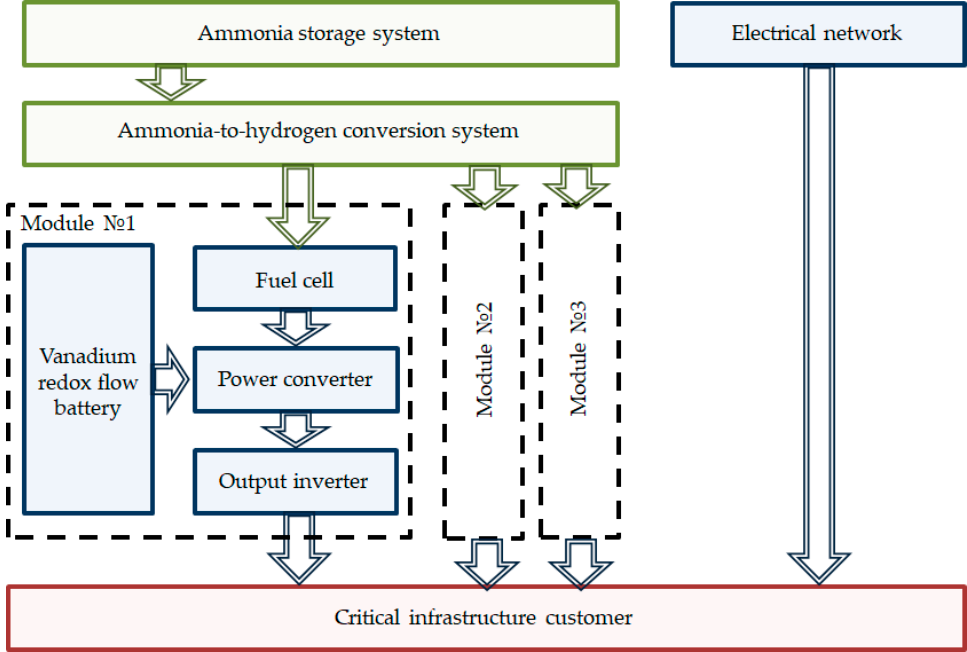
Figure 7. Prospective Fuel Cell-Based Local Power Source Structure for Critical Infrastructure